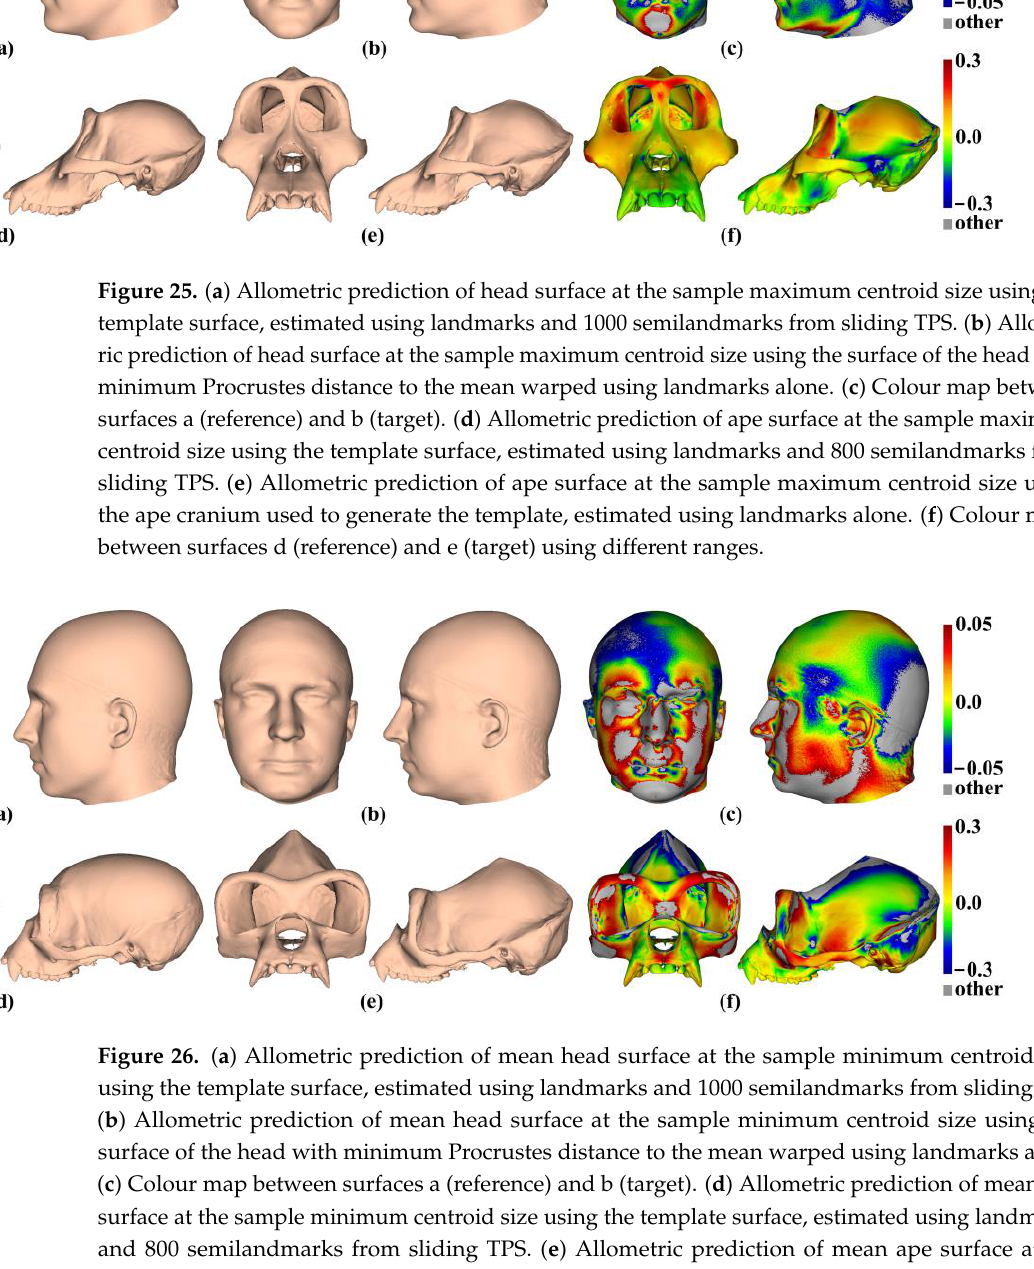
These warped surfaces were added to the PCAs of the mean and allometrically scaled